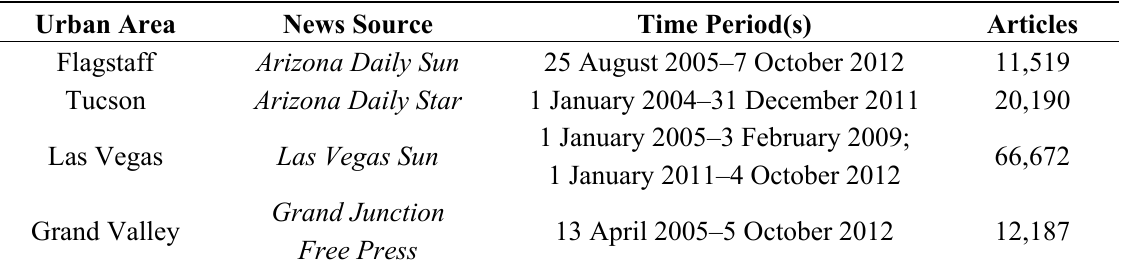
Table 3. Data sources and articles